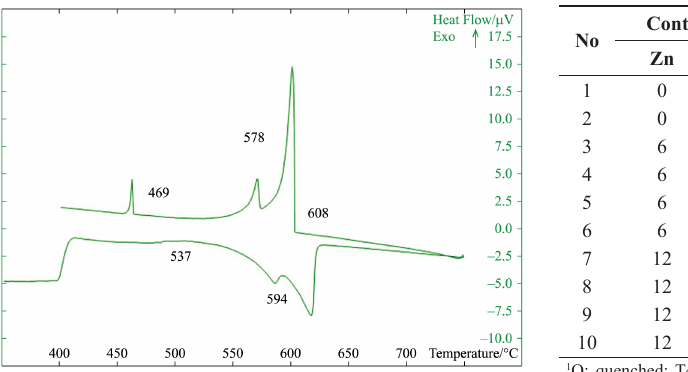
Figure 7. DSC-curves of the alloy Al-9%Zn-3.5%Mg-1%Ca.